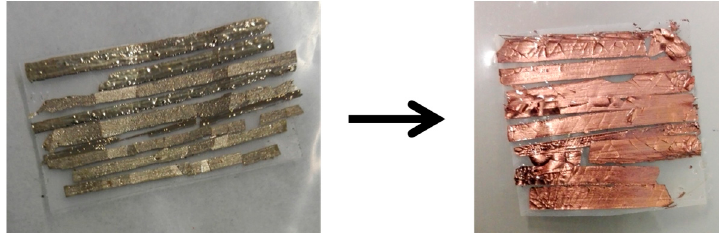
Figure 3. Examples of the external aspect of the Cu-Mg-Ca ribbons before and after chemical dealloying in 0.04 M H 2 SO 4 for 30 min.